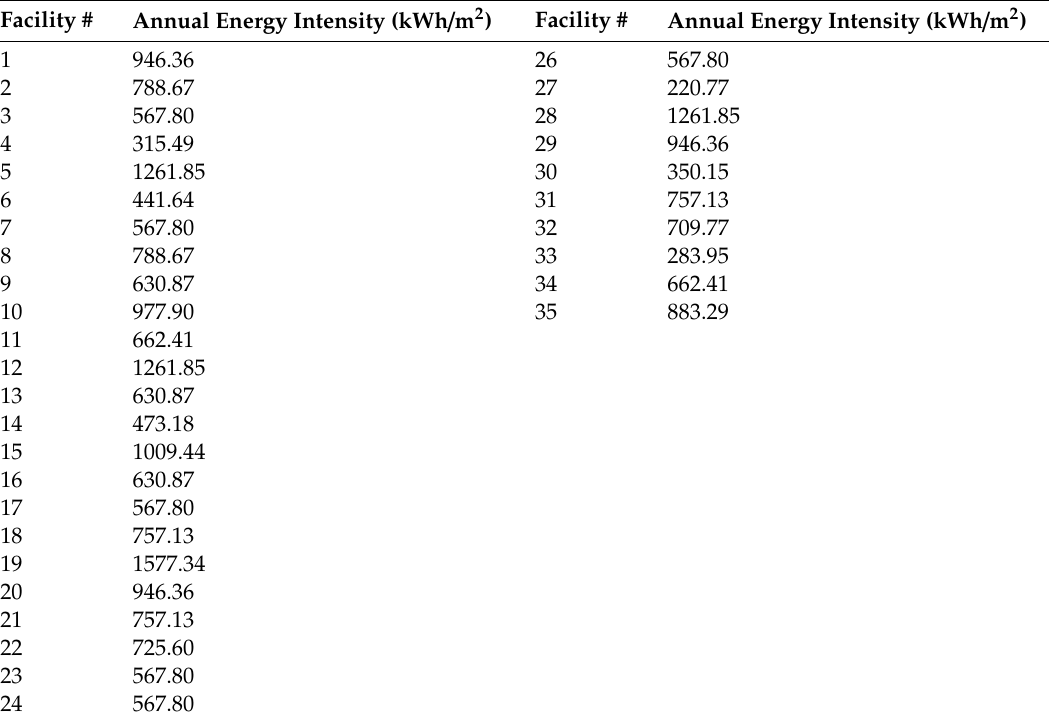
Table A1. Annual energy consumption for the 35 healthcare facilities in